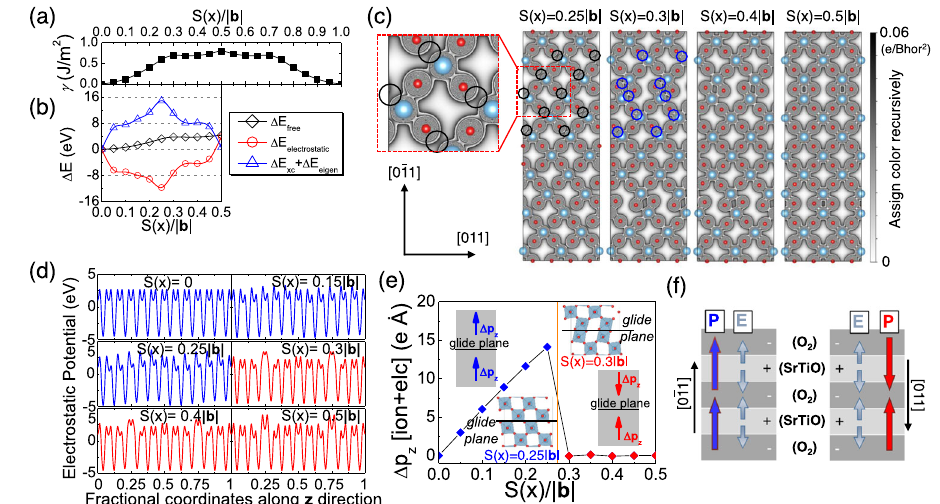
Fig. 2 | Local mis fi t energy calculations for SrTiO 3 . a Local mis fi t energies γ and b the variations of free energy Δ E free , electrostatic energy Δ E electrostatic , the sum of exchange-correlation energy and Kohn – Sham eigenvalues Δ E xc + Δ E eigen as a function ofnormalizedsheardisplacement S ( x )/| b |for [011](0 (cid:1) 11) system inSrTiO 3 . c The two-dimensionaldisplays ofthe chargedensitieson(100) Ti – O plane forthe supercell with the shear displacements S ( x ) of 0.25| b |, 0.3| b |, 0.4| b | and 0.5| b |. The circles mark the positions where the Ti – O bonds break [ S ( x )=0.25| b |] and recover [ S ( x )=0.3| b |]. d The planar averaged electrostatic potentials along z